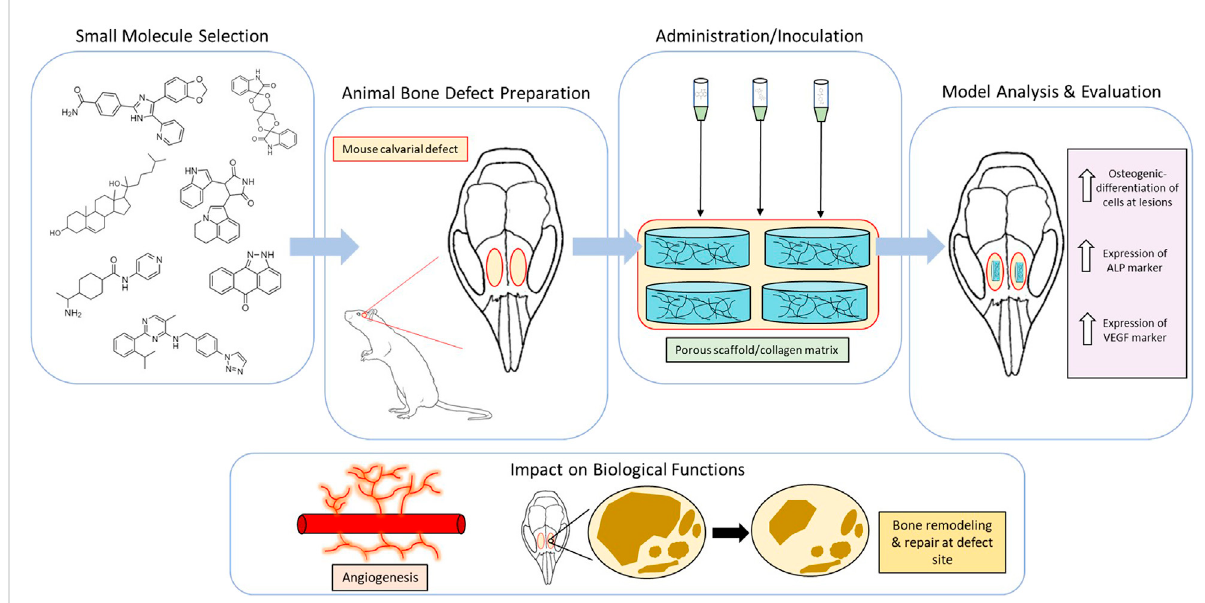
FIGURE 2 Example methodology of in vivo analysis for craniofacial and dentoalveolar tissue engineering. Meticulous selection of small molecules with favorable osteogenic properties and animal models involving defects of the craniofacial or dentoalveolar tissues. Scaffolds incorporated with